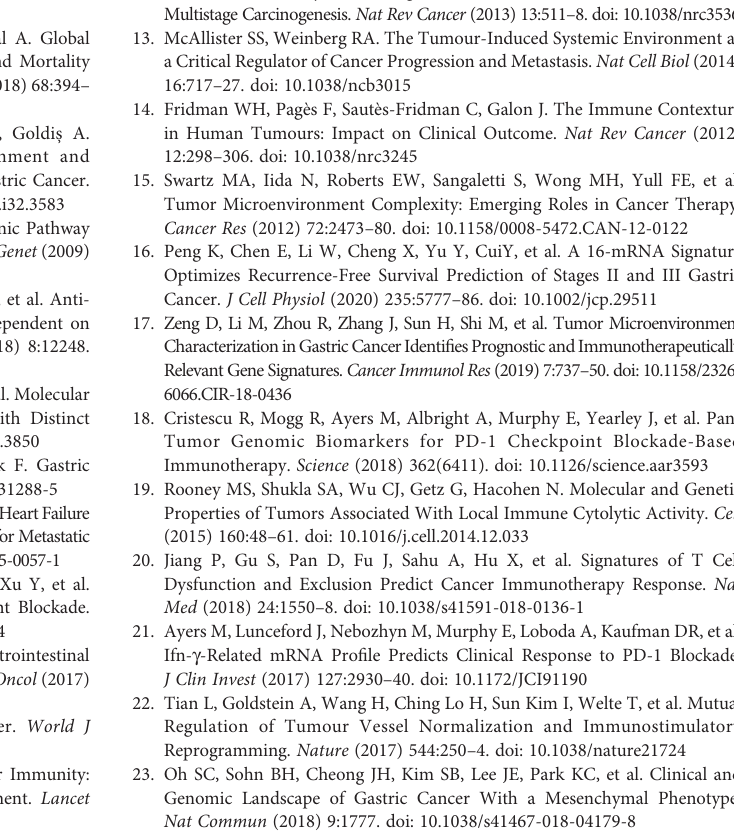
clusters of patients (cluster 1 n=132, cluster 2 n=116; Student ’ s t-tests). (F) Analysis of the difference in tumor purity scores between the two clusters (cluster 1 n=132, cluster 2 n=116; Student ’ s t-test). All data were from the GSE15460 dataset. Supplementary Figure 5 | Differential gene expression analysis and differential gene enrichment analysis of the two clusters. (A) Volcano map of differentially expressed genes between the two clusters (Student ’ s t-tests FDR < 0.05, log2fold change (FC) > 1). (B) Heatmap of differentially expressed genes between the two clusters (cluster 1 n=132, cluster 2 n=116). (C) Biological process (BP) enrichment analysis of differentially expressed genes. (D) Cellular component (CC) enrichment analysis of differentially expressed genes. (E) Molecular function (MF) enrichment analysis of differentially expressed genes. (F) KEGG enrichment analysis ofdifferentially expressed genesbetween the two clusters. All data are from the GSE15460 dataset. Supplementary Figure 6 | Different datasets were applied to validate the multivariate Cox risk model. (A, B) Least absolute shrinkage and selection operator (LASSO) regression analysis. (C) Survival curves for different risk groups in the validation set (high-risk n=127, low-risk n=145; log-rank test). (D) Relationship between the patient survival time, survival status and risk score validation set (high- risk n=127, low-risk n=145). (E) Expression heatmap of 7 genes with different risk groups for the modeling validation set (high-risk n=127, low-risk n=145). (F) Time- dependent ROC analysis of the risk score in validation-set patients. (G) Overall survival curves in GSE84437 datasets based on the same cutoff value used to obtain the training set risk score (high-risk n=222, low-risk n=211; log-rank test). (H) OverallsurvivalcurvesinTCGAdatasetsbasedonthesamecutoffvalueusedto obtain the training set risk score (high-risk n=136, low-risk n=187; log-rank test).